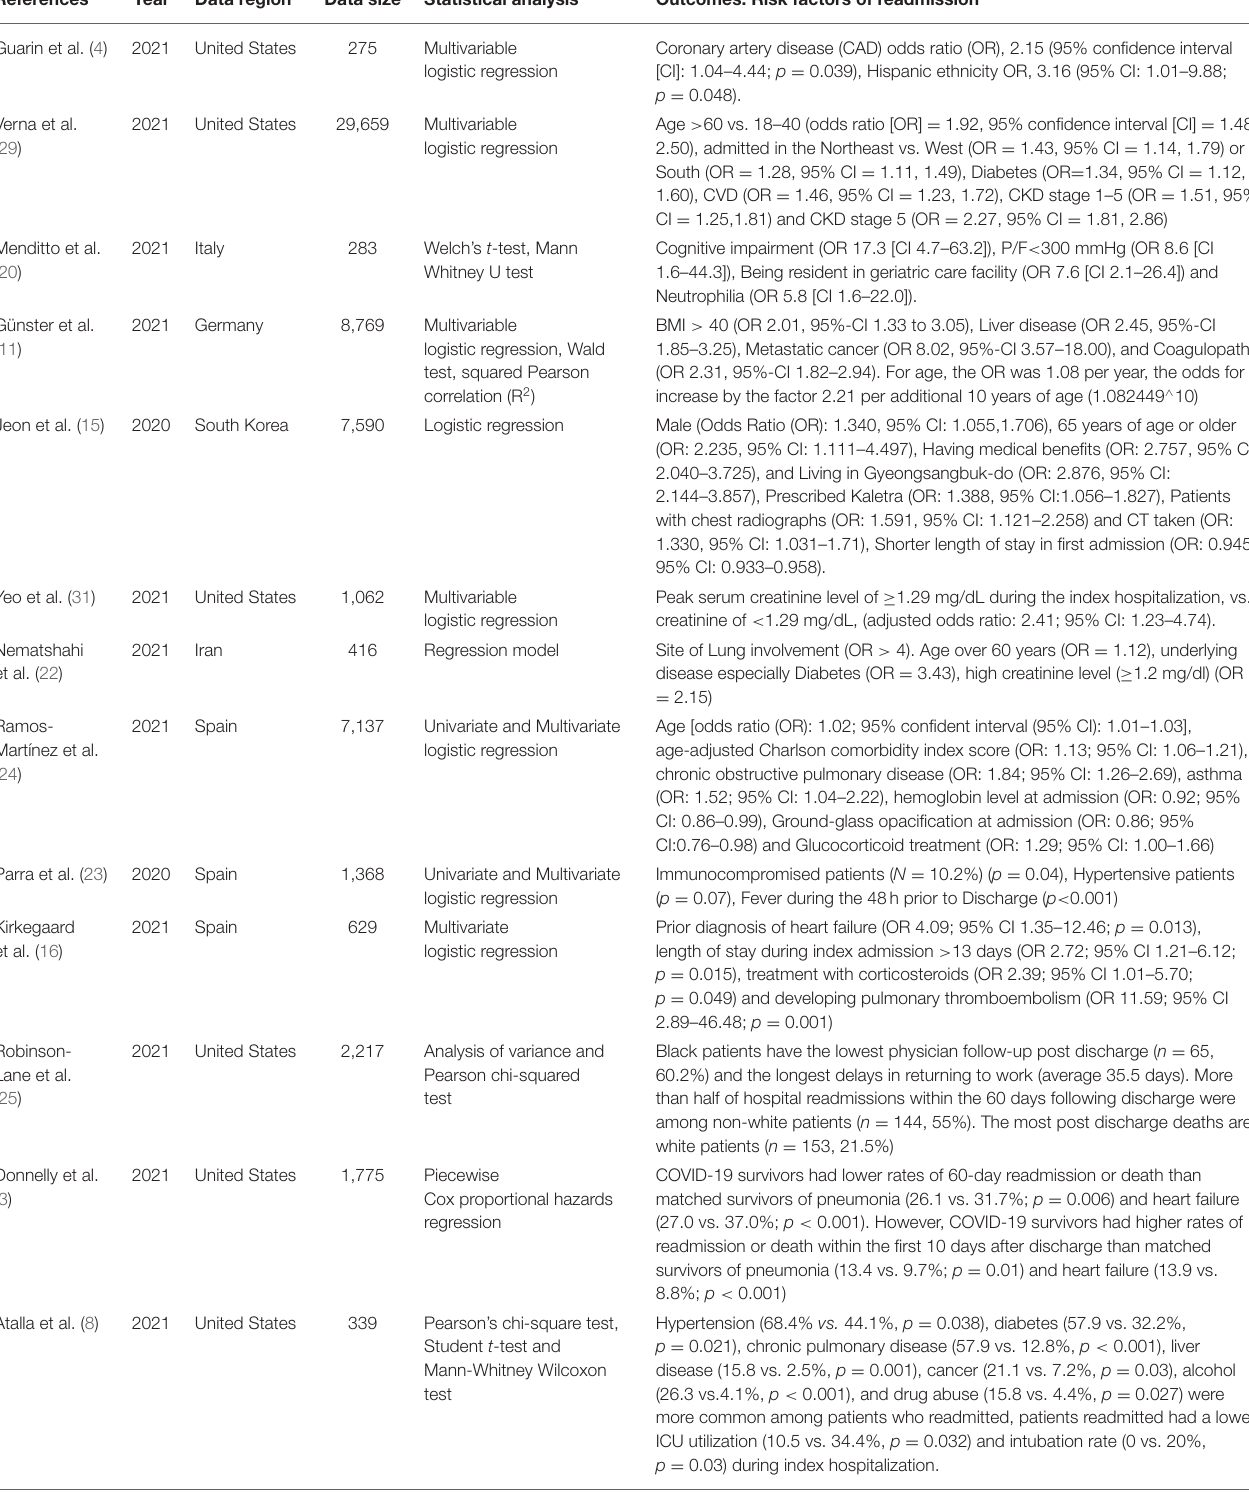
TABLE 3 | Table of review on general readmission risk factors post COVID-19